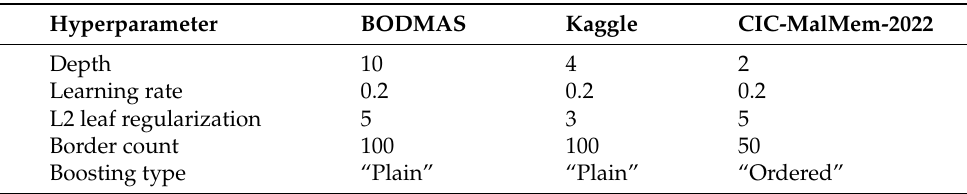
Table 4. The final learning parameters of CatBoost used for each dataset after performing a ran- dom search .